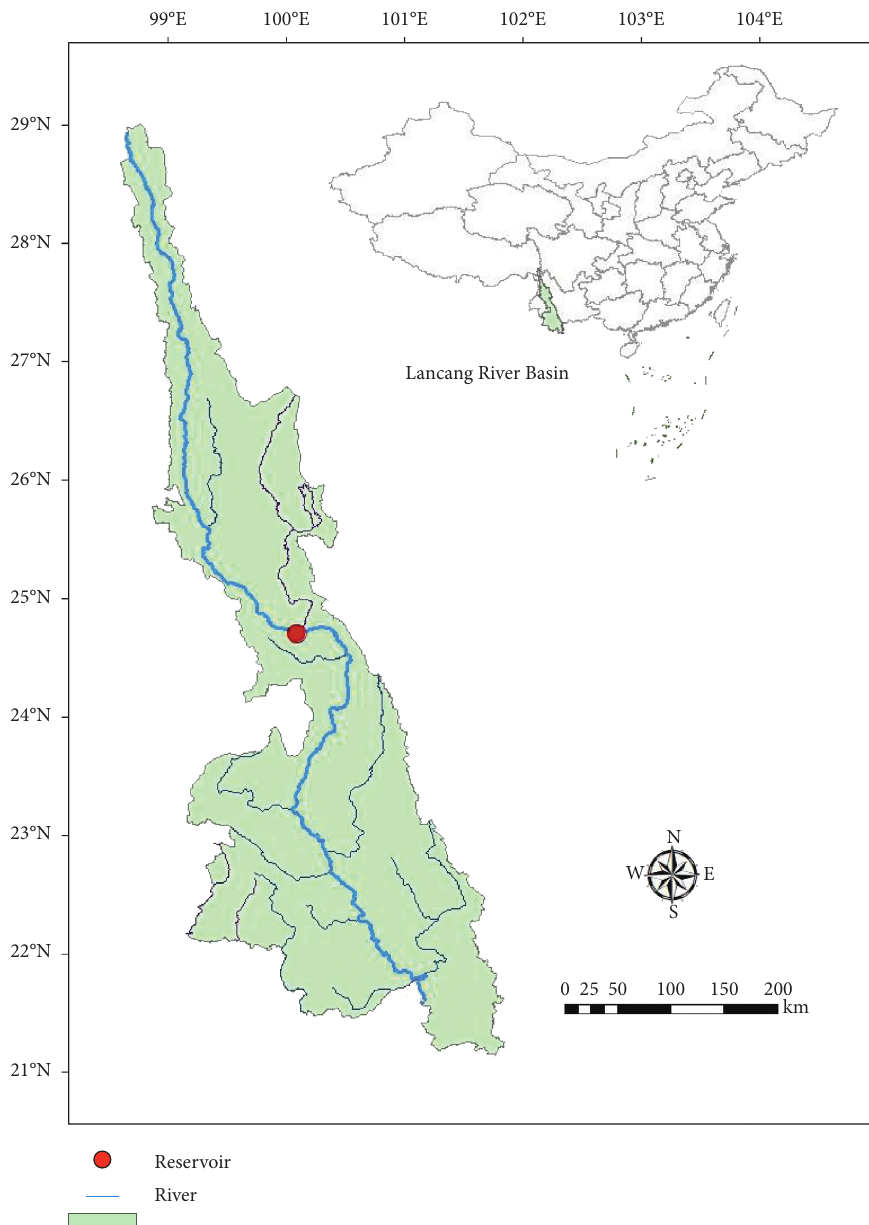
Figure 3: Lancang River basin in Yunnan and the Xiaowan